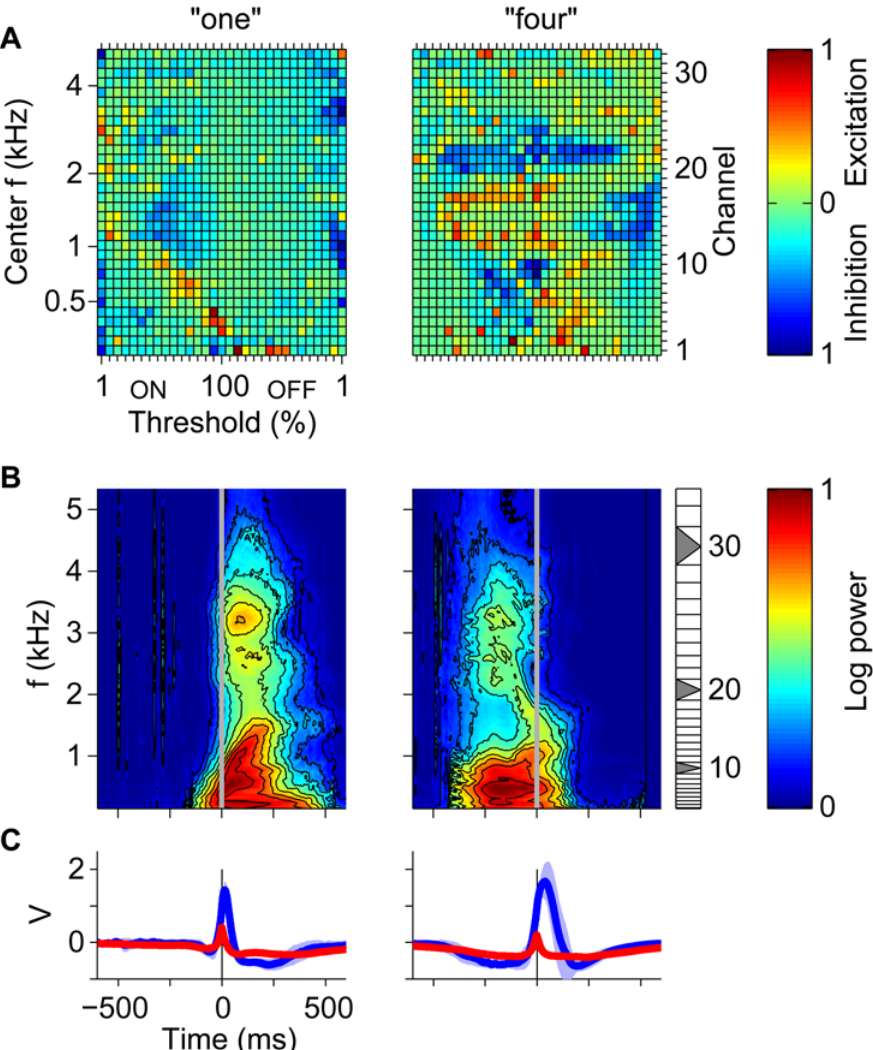
Figure 7. Speech-recognition task. (A) Learned synaptic peak conductances. Each pixel corresponds to one synapse characterized by its frequency channel (right y -axis) and its onset (ON) or offset (OFF) afferent power threshold level ( x -axis, in percent of maximum signal powers [see Materials and Methods]). Learned peak conductances were color coded with excitatory (warm colors) and inhibitory conductances (cool colors) separately normalized to their respective maximal values (color bar). The left y -axis shows the logarithmically spaced center frequencies (Mel scale) of the frequency channels. (B) Spike-triggered target stimuli (color-code scaled between the minimum and maximum mean log power). (C) Mean voltage traces for target (blue, light blue 6 1 s.d.; spike triggered) and null stimuli (red; maximum